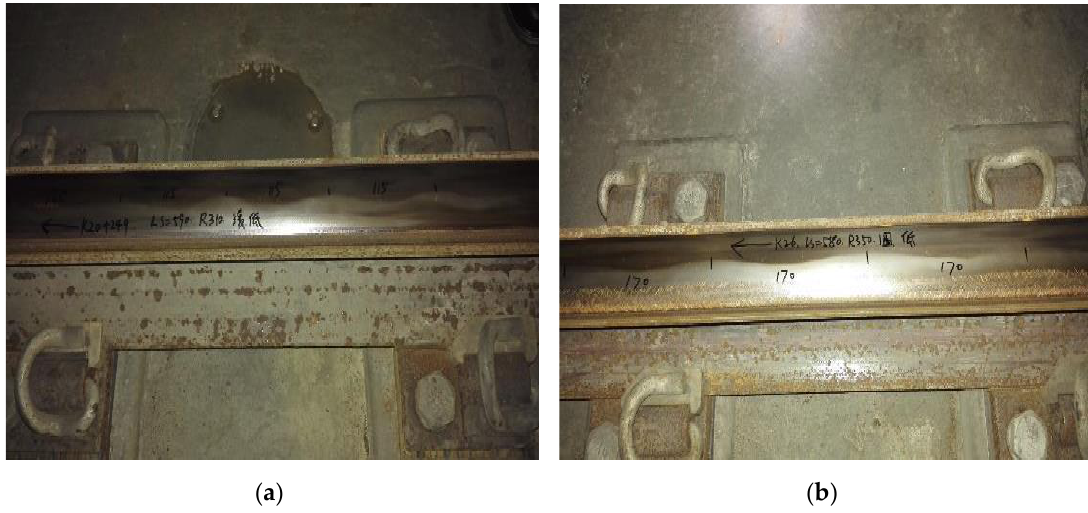
Figure 16. Rail corrugation in different sections: ( a ) section 1; ( b ) section 2.